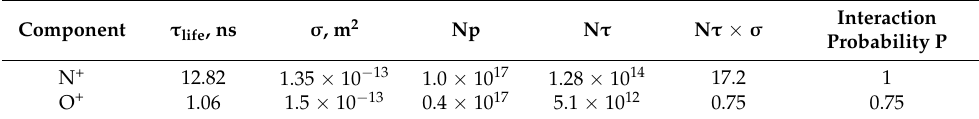
Table 3. Main parameters of radiation interaction with the excited